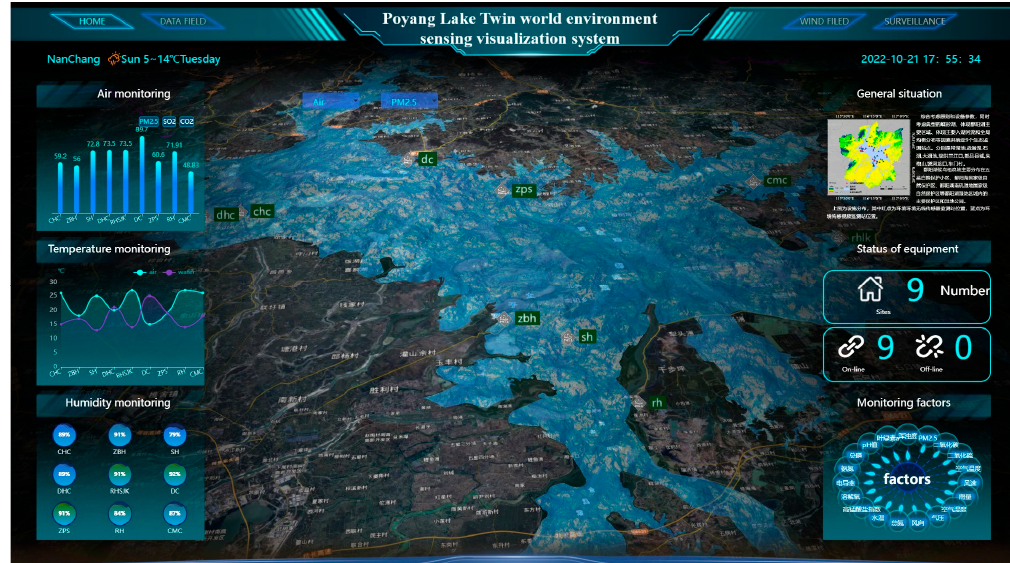
Figure 5. Digital twin world environmental sensing data visualization system of Poyang Lake.